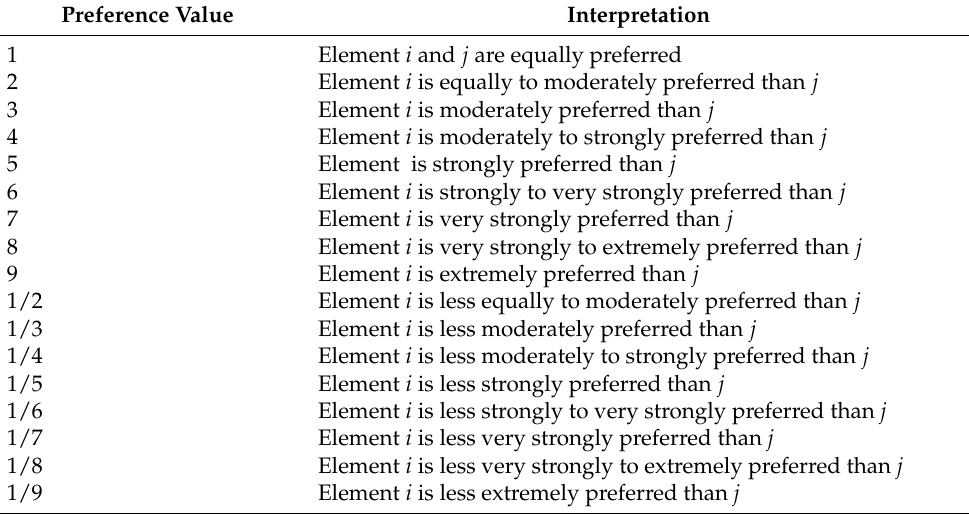
Table 1. Saaty’s AHP